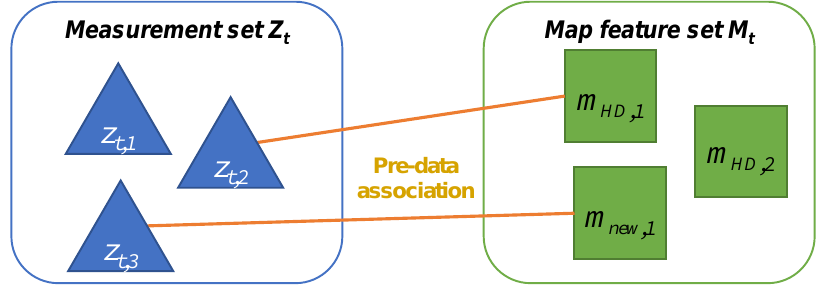
Figure 6. Pre-data association between the measurement set and map feature